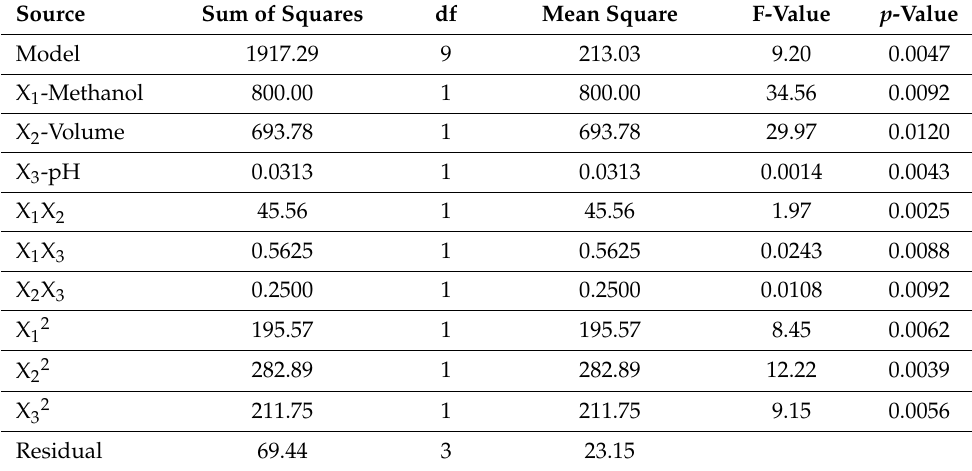
Table 2. Analysis of variance for the extraction yield of the